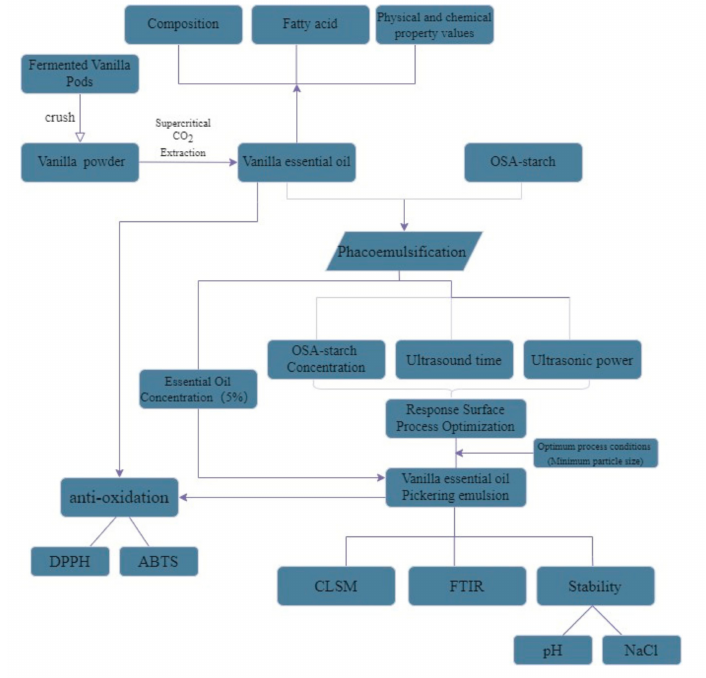
Figure 2. Experimental design